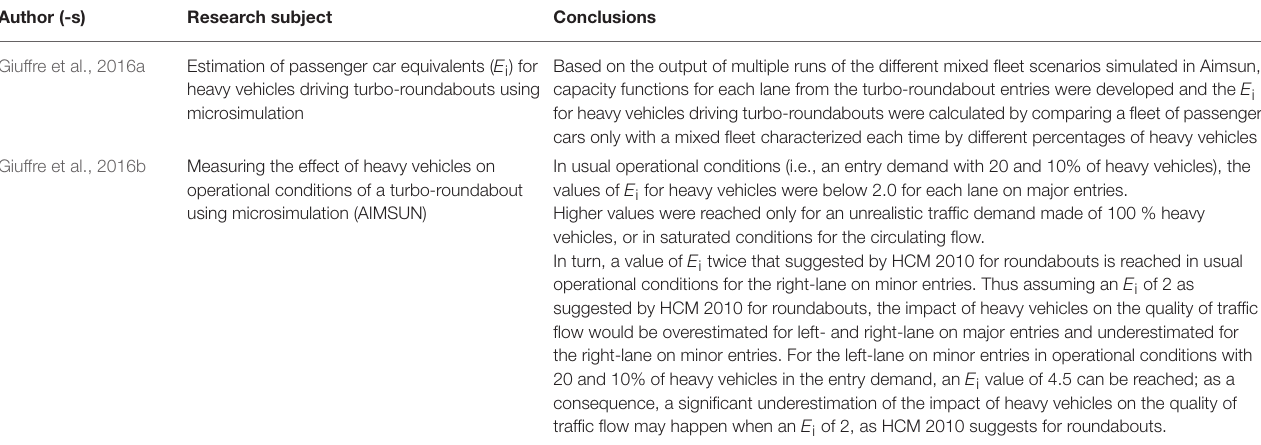
TABLE 1 | Passenger car equivalent factors for turbo roundabouts—research